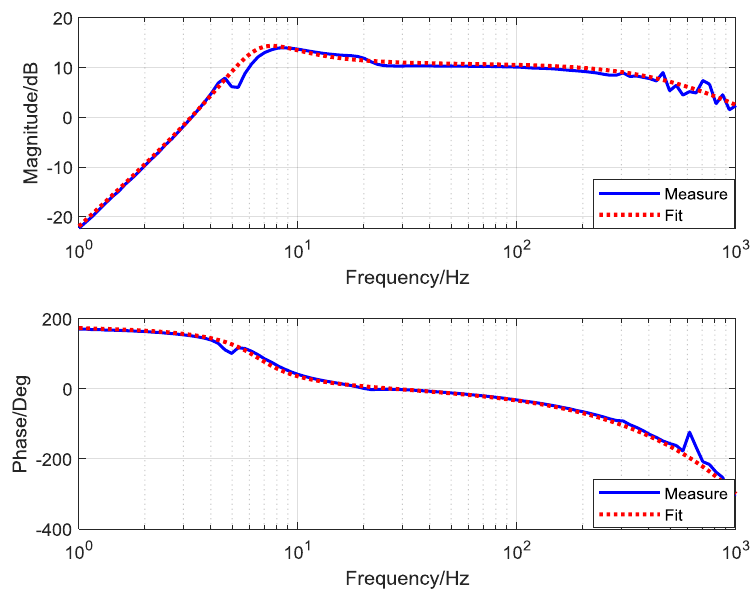
Figure 9. The open-loop characteristic acceleration response of the controlled object.